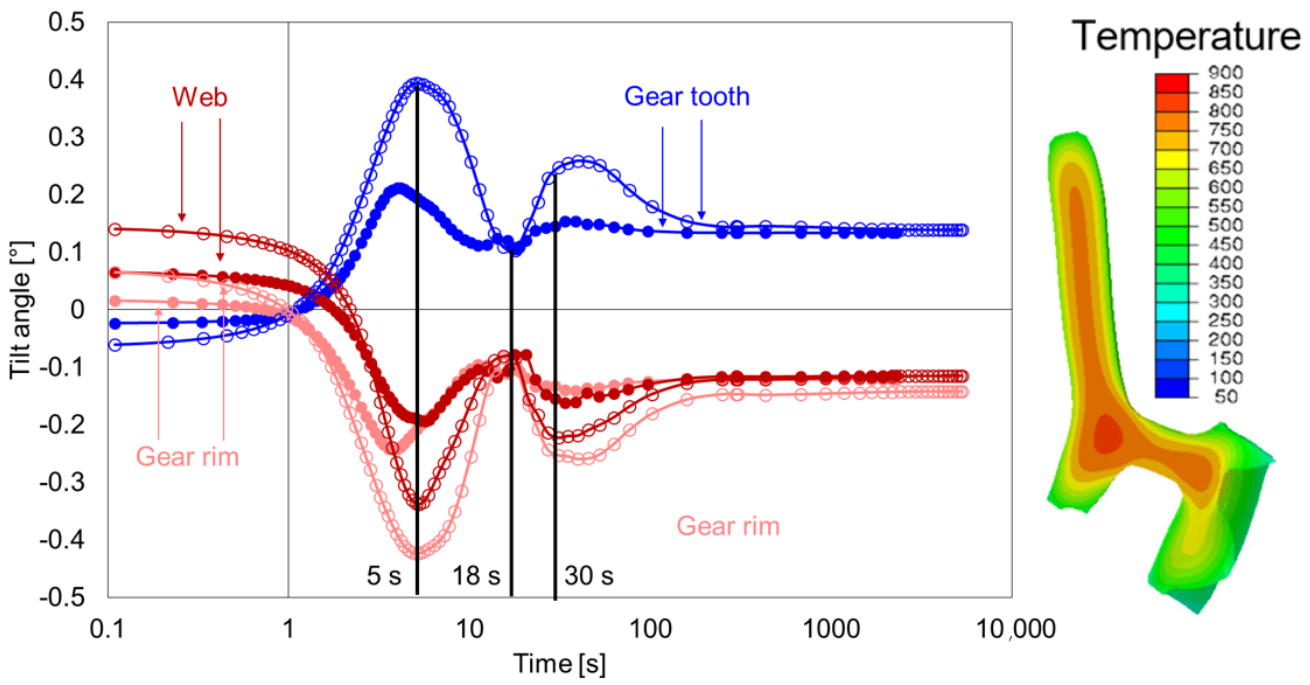
Figure 18. Tilt angle development of web, gear rim, and gear tooth for the geometry type G3 (circle with fill) and compar- ison with geometry type G5 (circle without fill) during quenching ( left ), and temperature distribution and contour plot for G3 and G5 after 5 s ( right ).